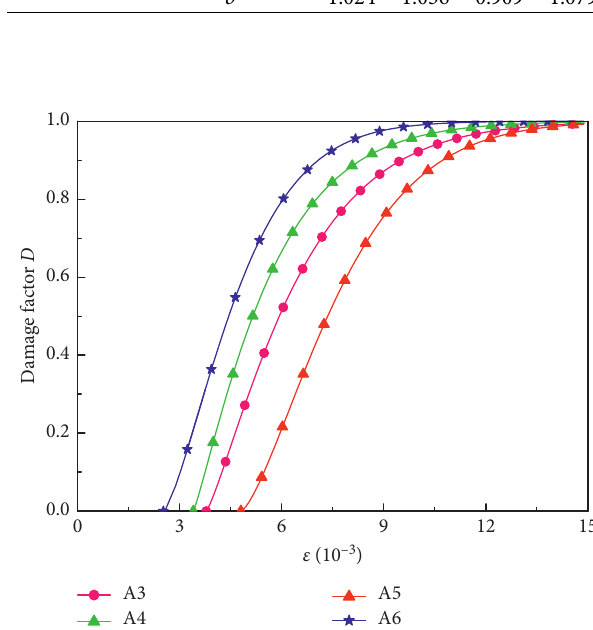
Figure 10: D − ε curve of HPFRC under the same strain rate.